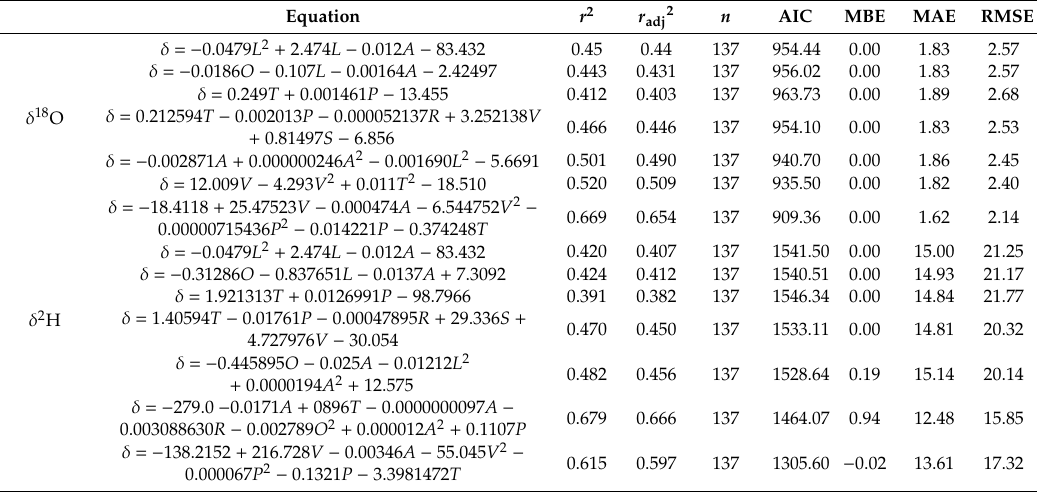
Table 2. Model equations of δ 2 H and δ 18 O in bottled water across China. r 2 = coefficient of determination; r adj2 = adjusted determination coefficient; n = The total number of our sampling sites; AIC = Akaike’s Information Criterion; MAE = mean absolute error; MBE = mean bias error; RMSE = root mean square error.